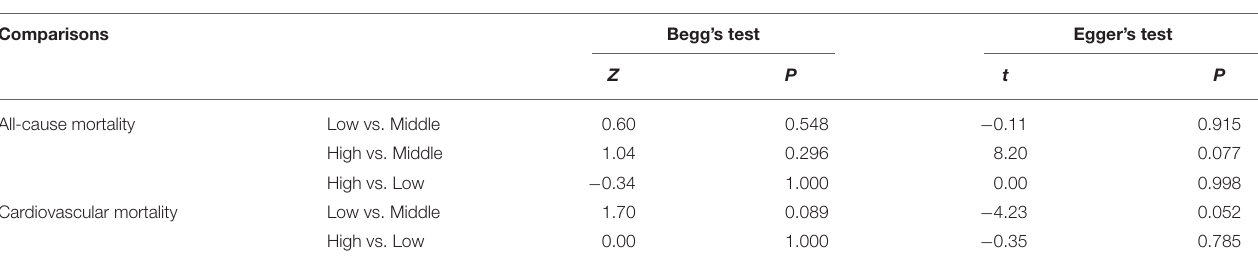
TABLE 4 | Publication bias: Begg’s test and Egger’s test.